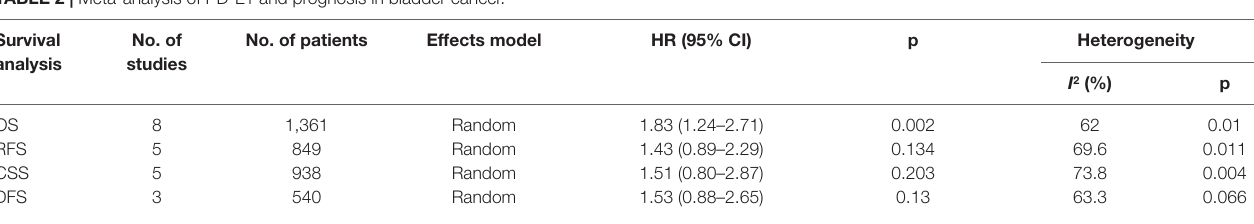
TABLE 2 | Meta-analysis of PD-L1 and prognosis in bladder cancer. Survival